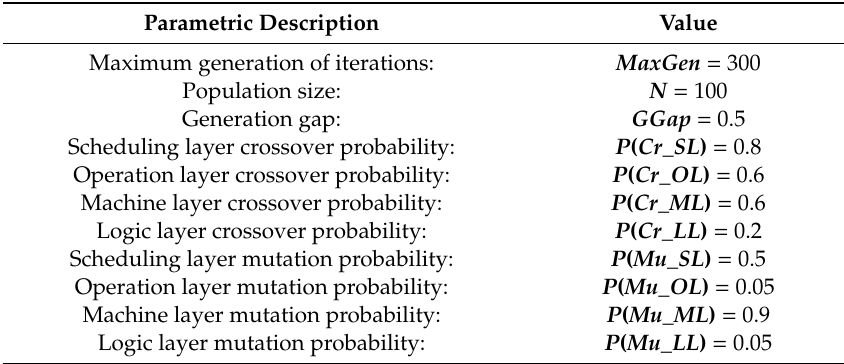
Table 6. The algorithm parameters in case